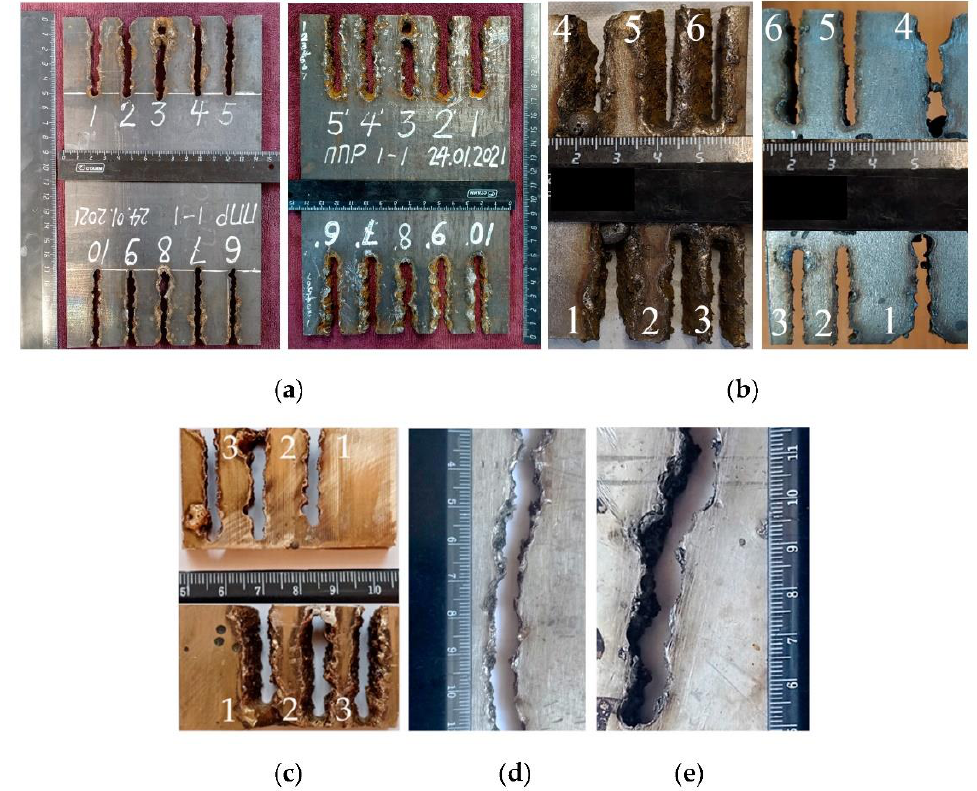
Figure 17. Outside and backside of the samples after cutting: ( a ) 10KhSND steel of 10 mm, automatic cutting with PPR- APL1-1; ( b ) AISI 304L steel of 16 mm, automatic cutting with PPR-APL1-1; ( c ) CuAl5 alloy of 10 mm, automatic cutting with PPR-APL1-2; ( d , e ) AlMg4.5Mn0.7 of 6 and 12 mm, semi-automatic cutting with PPR-APL1-3, current of 240 A, volt- age of 38